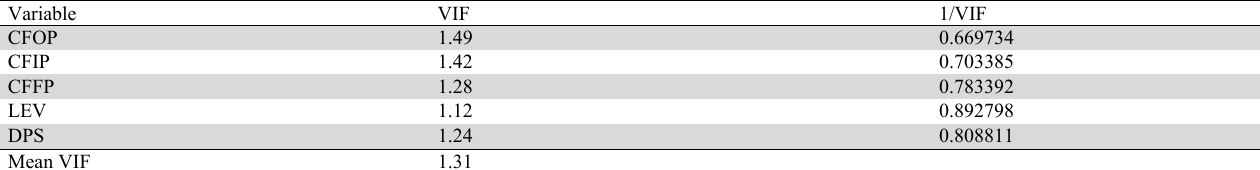
Variance Inflation Factors (VIF) results